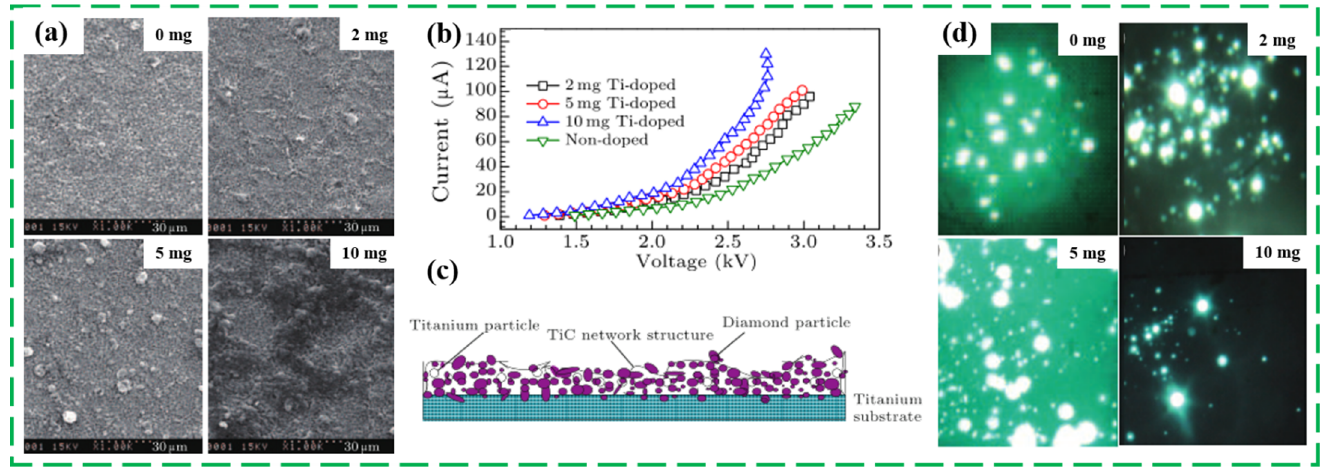
Figure 9. SEM images ( a ), field emission curves ( b ), microstructure model ( c ) and luminous photos ( d ) of the Ti-doped ND cathode film with different amounts of Ti powder, i.e., 0 mg, 2 mg, 5 mg, and 10 mg [92]. Table 2. The field emission properties of intrinsic/doping ND films in recent reports.